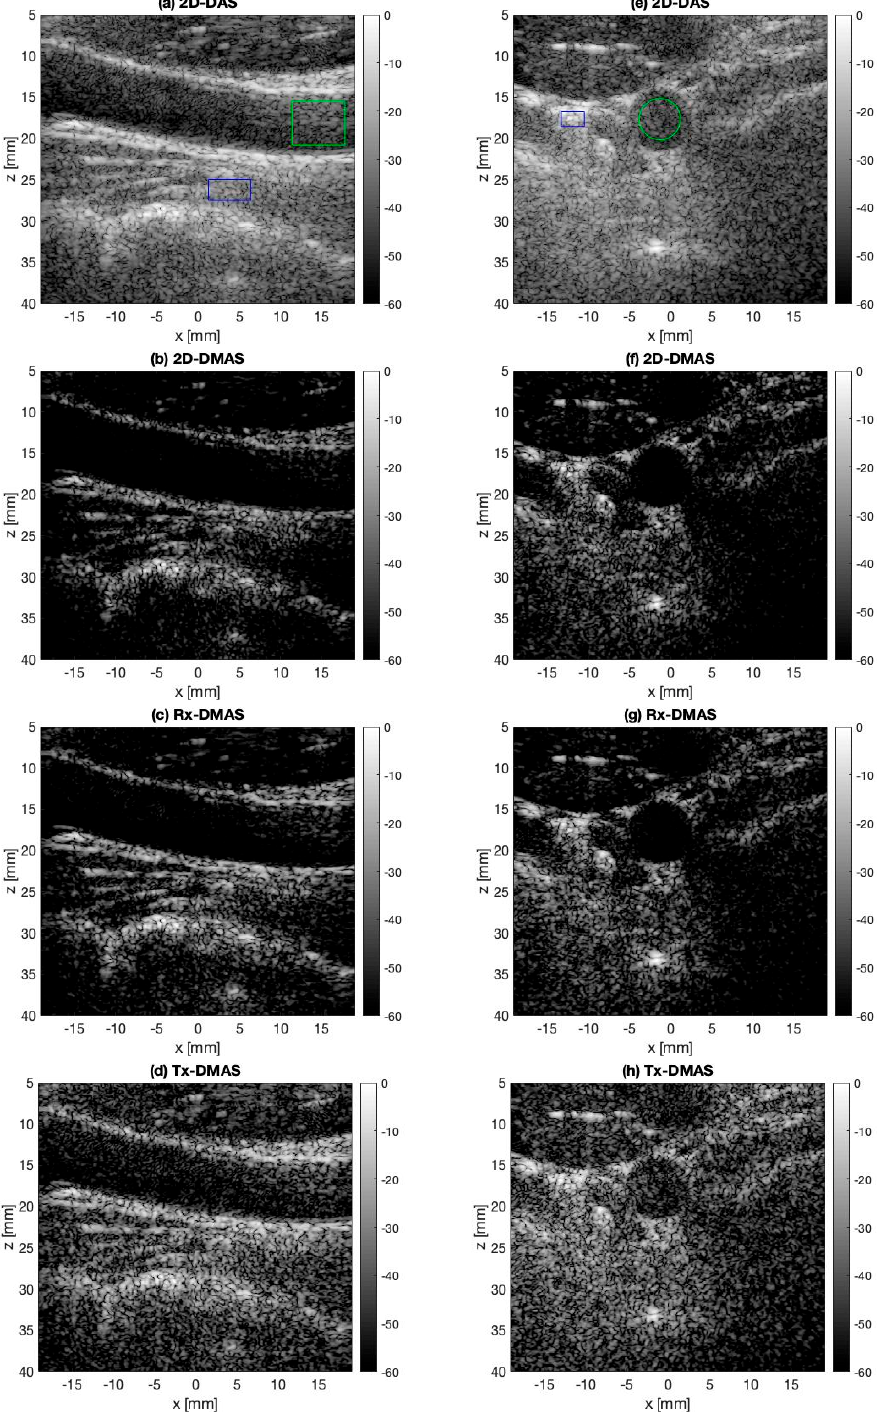
Figure 5. Experimental B-mode images of in vivo carotid artery for 2D-DAS, Rx-DMAS, Tx-DMAS, and 2D-DMAS beamforming: The p value in DMAS beamforming is fixed to 2.0.